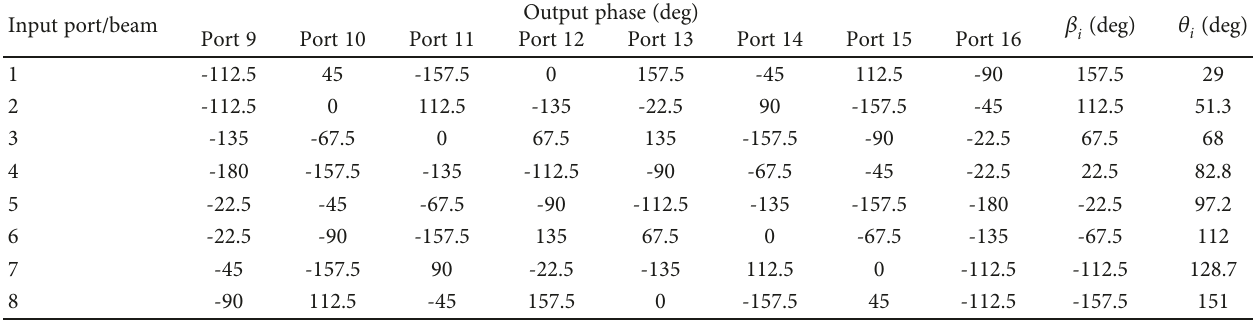
θ × 8 BM. i of the 8